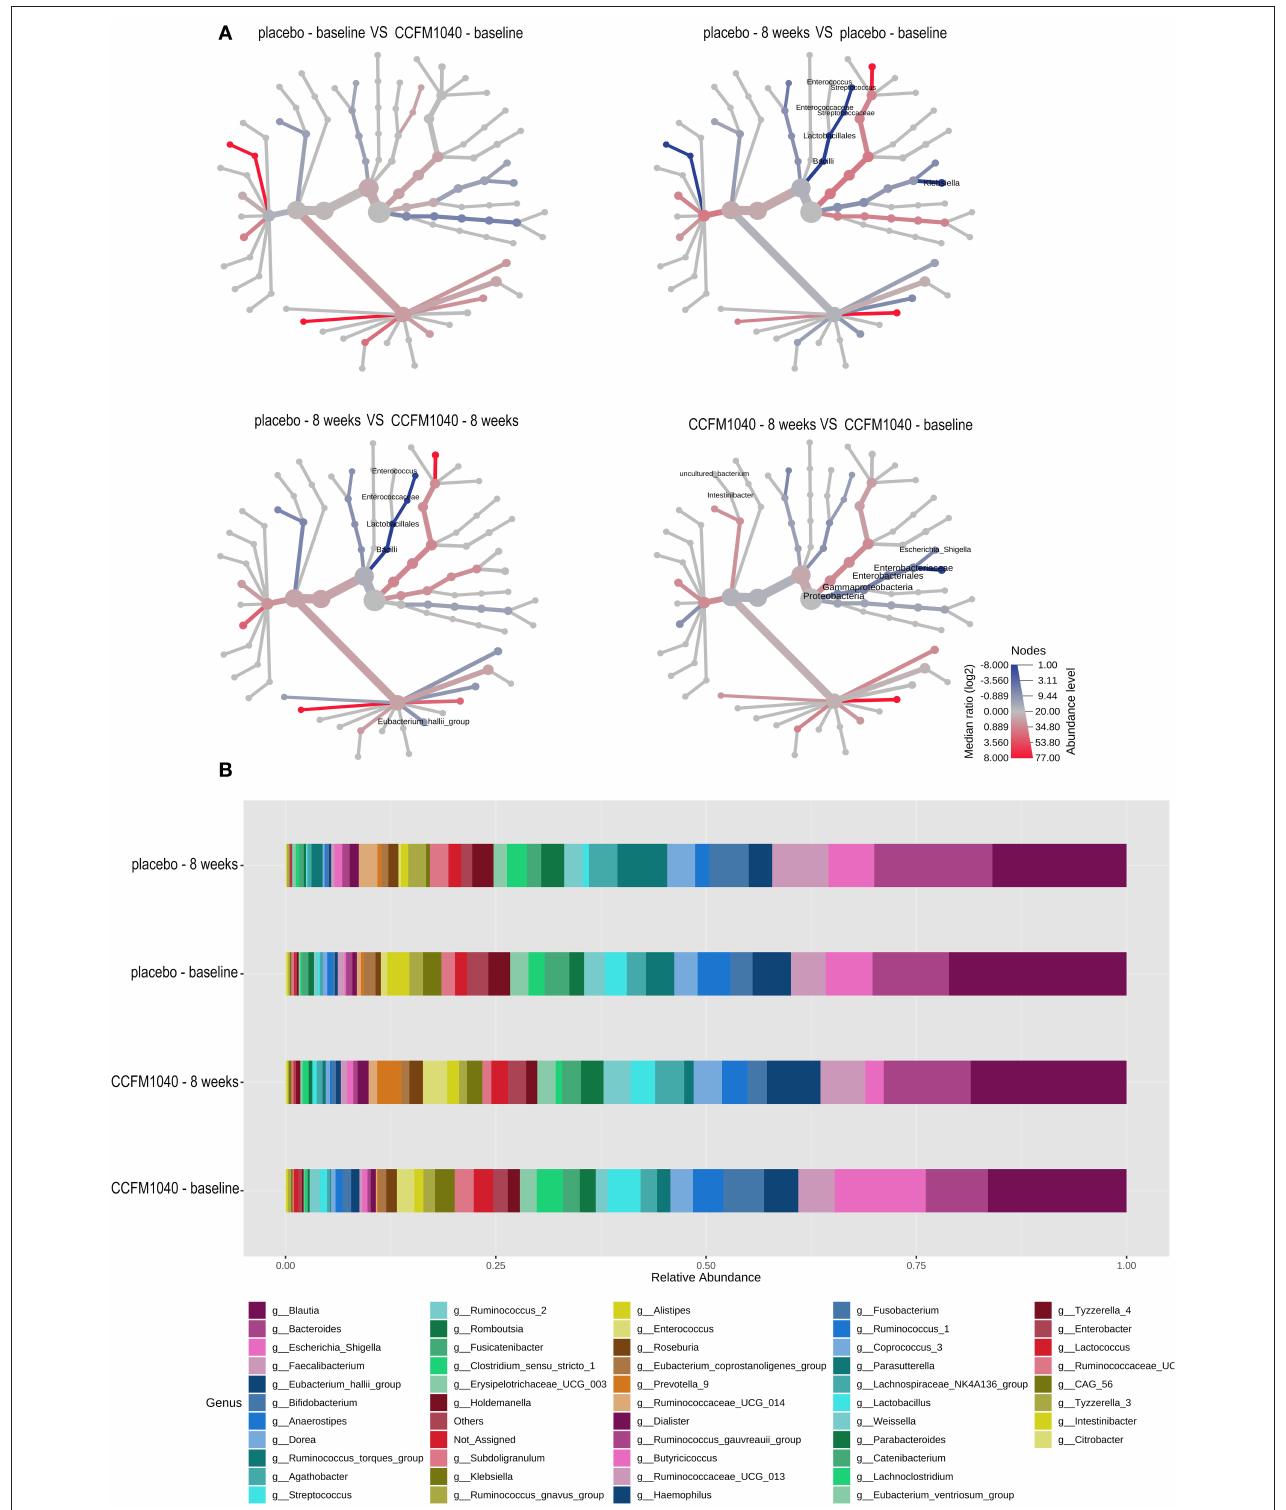
FIGURE 5 | Effect of CCFM1040 and placebo on the composition of gut microbiota in patients with AR. (A) The different abundance of microbe between the two groups was shown in the heat tree. Nodes marked with text represent significance ( P < 0.05) between the two groups. (B) Effect of CCFM1040 and placebo on the abundance of the bacterial genus. AR, allergic